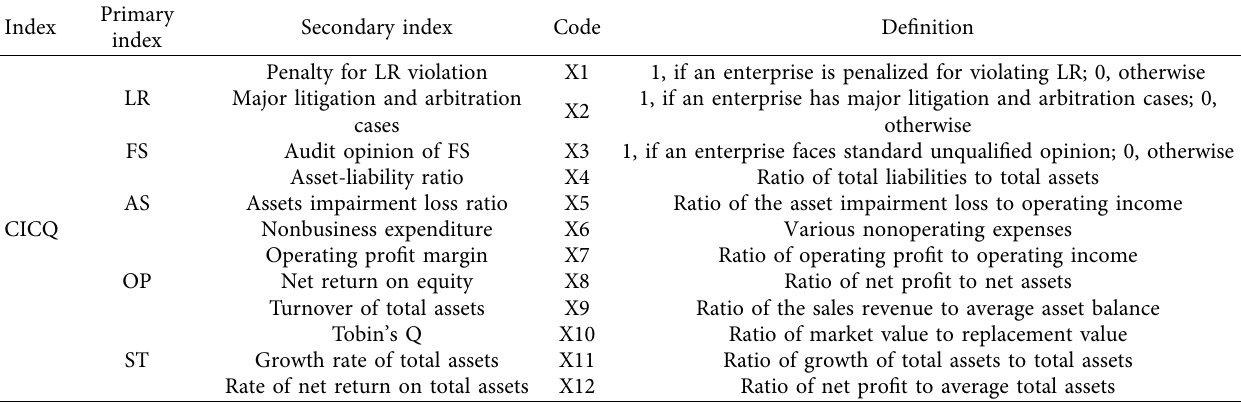
Table 1: CICQ evaluation